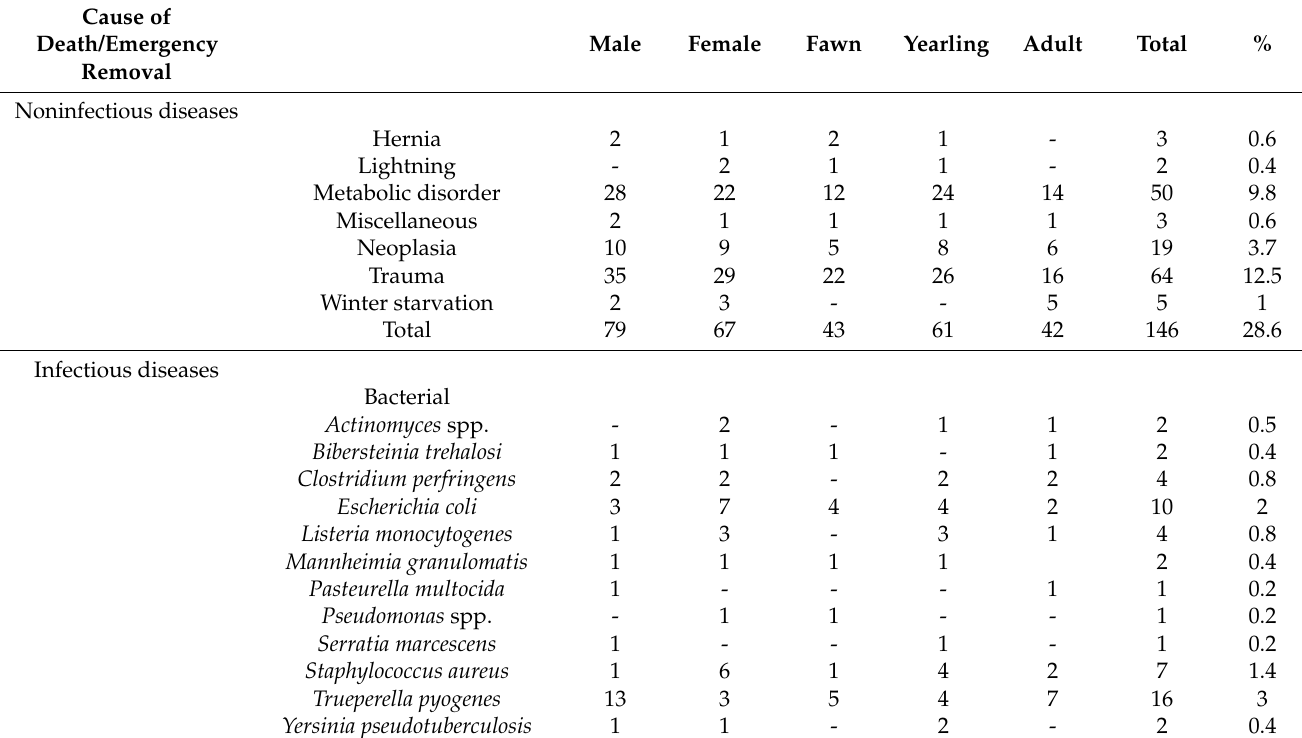
Table 2. Overview of the causes of death or emergency removal associated with the main disease diagnosed in roe deer in Slovenia,